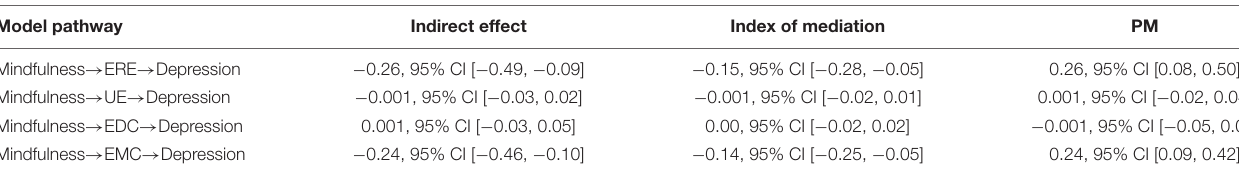
TABLE 4 | Indirect effect and sizes for model pathways between mindfulness and depression with EI subscales as the mediating variables. Model pathway Indirect